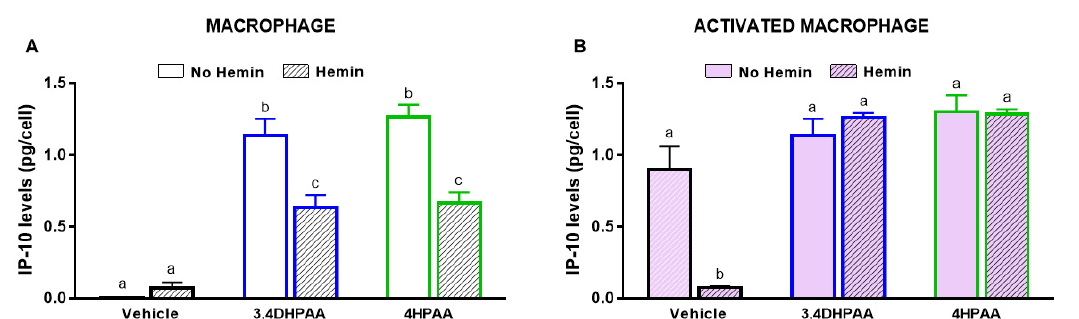
Figure 7. 3,4DHPAA and 4HPAA induce IP-10 release in macrophages and hemin reduces IP-10 release in macrophages. Levels of IP-10 in the media of ( A ) macrophages and ( B ) activated macrophages incubated with 10 μ M 3,4DHPAA or 10 μ M 4HPAA, in the presence or absence of 10 μ M hemin for 72 h. Values with different superscript letters (a and b) indicate significant differences ( p < 0.05) between groups. For all bars with the same letter, the difference between the means is not statistically significant. 3,4DHPAA, 3,4-dihydroxyphenylacetic acid; 4HPAA, 4-hydroxyphenylacetic acid; IP-10, interferon- γ -inducible protein 10.